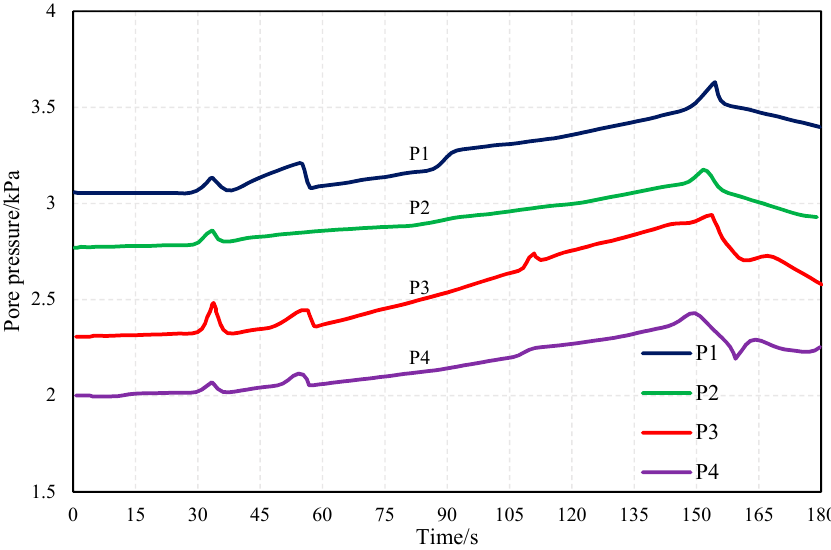
Figure 19. Measured pore pressure in Model 13-15.